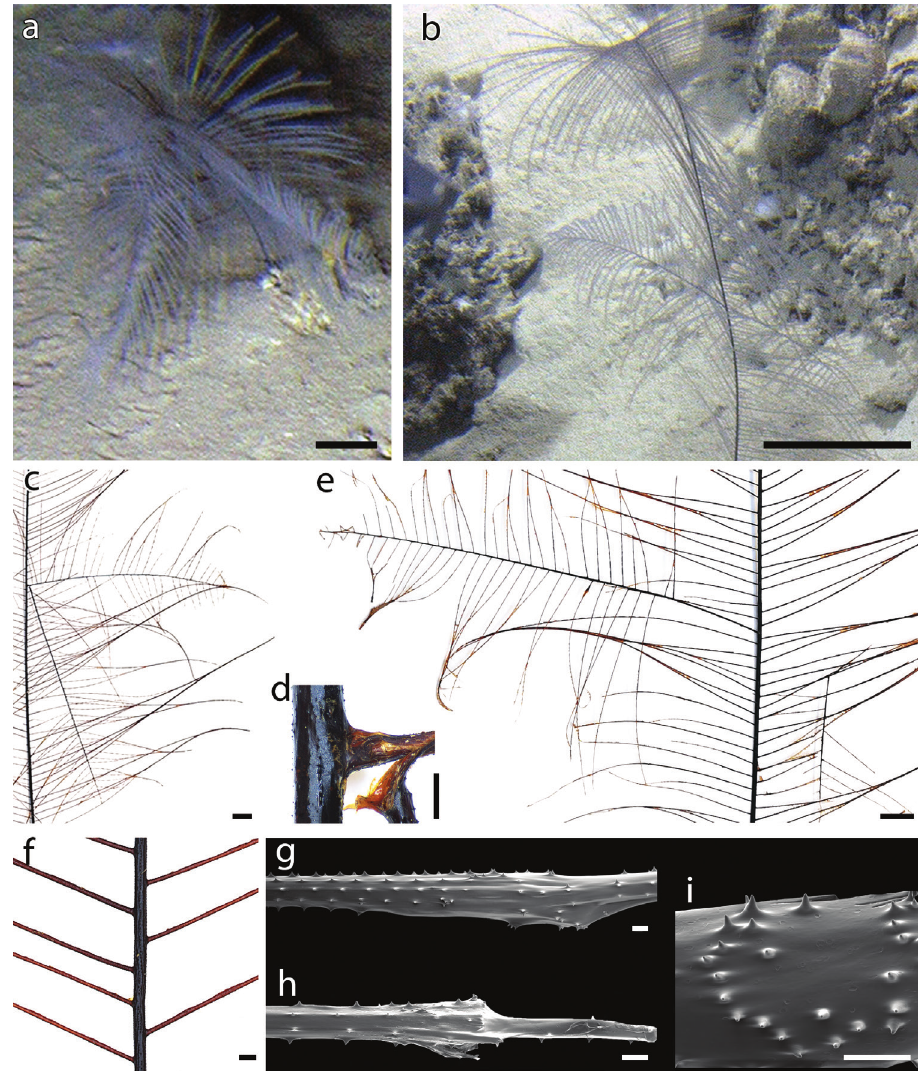
Figure 3. Branching and damages in Bathypathes thermophila sp. nov. a example of a colony in situ with different branches. Holotype (MNHN-IK-2016-45) b ramification observed in situ c ramification at the middle of the colony with d detail of the ramification. Paratype MUZAC-6665 e primary branch (on the left) and secondary branch (on the right) f example of two pinnules present on the same side of the stem with respect to the alternate pattern g cicatricial nodule on a pinnule h narrowing of the pinnular section possibly due to an injury and a subsequent recovery i spines arranged irregularly over a skeletal scar. Scale bars: 10 cm ( a, b ); 1 cm ( c, e ); 1 mm ( d, f ); 100 μm ( g–i